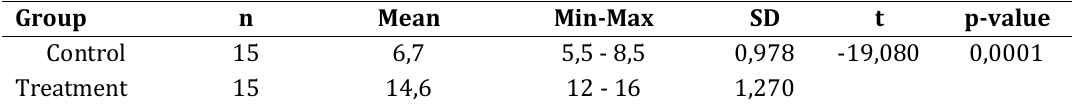
The Effect of Application of Tri-Core Breastfeeding Models on Primiparas on Willingness to Breastfeed in the COVID-19 Era in the Working Area of Public Health Centre I East Denpasar Group